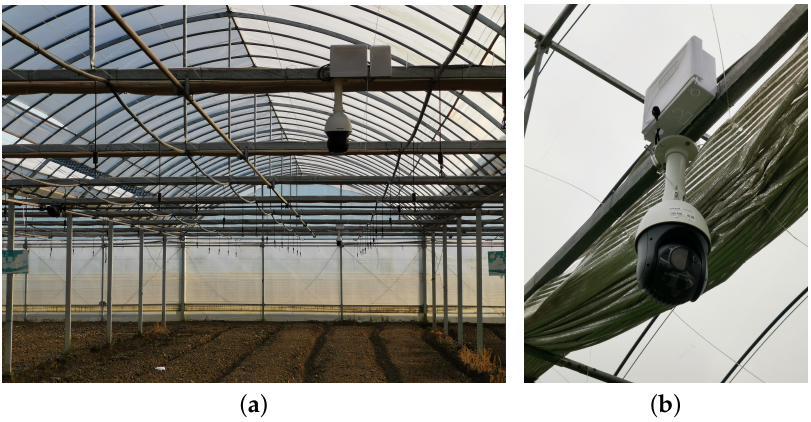
Figure 1. Installation of camera in greenhouse. Sub-figure ( a ) shows the installation location in the greenhouse and Sub-figure ( b ) shows the camera